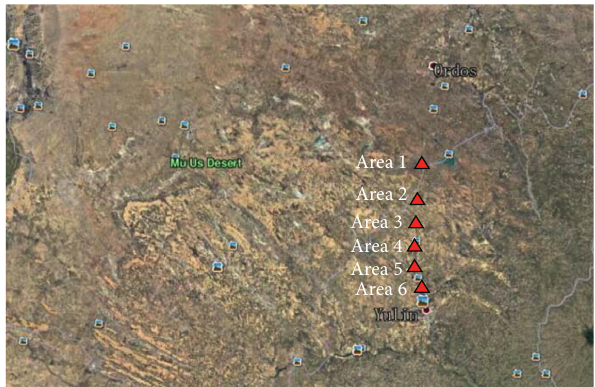
Figure 1: Test site in the Mu Us Desert of China (https://map.